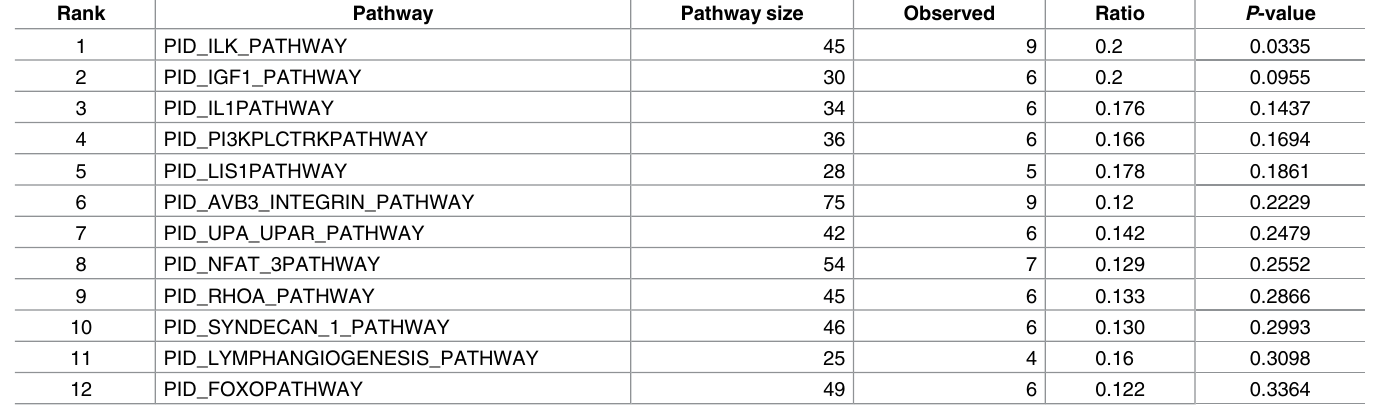
Table 5. Top-ranked pathways by PID analysis.